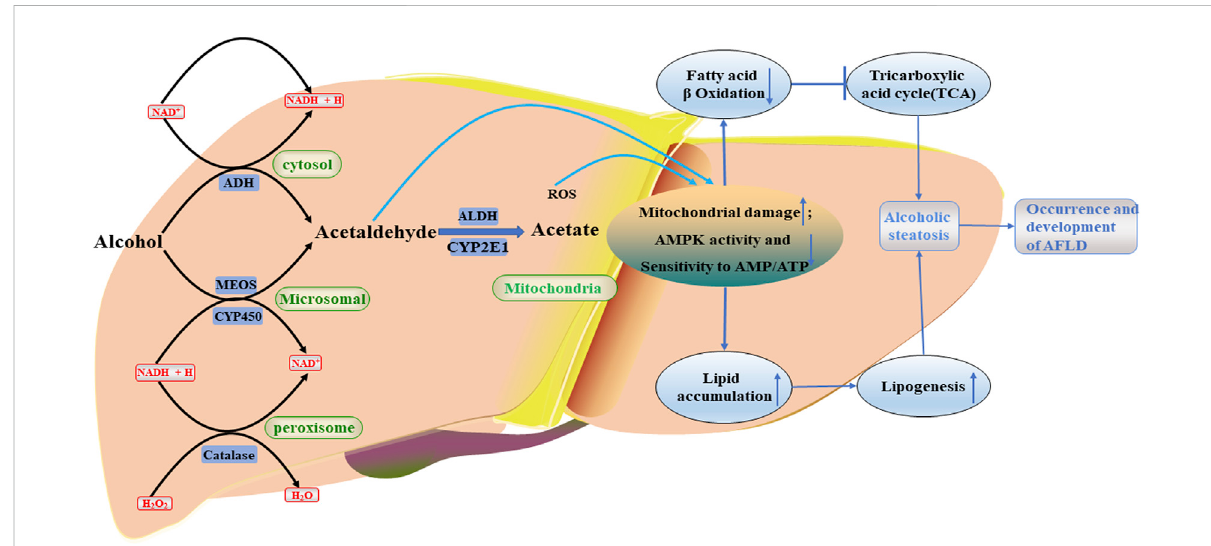
FIGURE 2 Occurrence and development of AFLD. Alcohol metabolites, including acetaldehyde, will further damage mitochondria, reduce AMPK activity and sensitivity to AMP/ATP, and cause serious lipid accumulation. ROS, reactive oxygen species; CYP2E1, the cytochrome P4502E1; ADH, alcohol dehydrogenase; ALDH, aldehyde dehydrogenase; NADPH, reduced nicotinamide adenine dinucleotide phosphate; NAD + , oxidized nicotinamide adenine